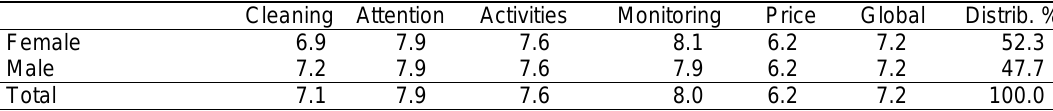
Table 7. Assessment of sports facilities by gender (2017). General report.